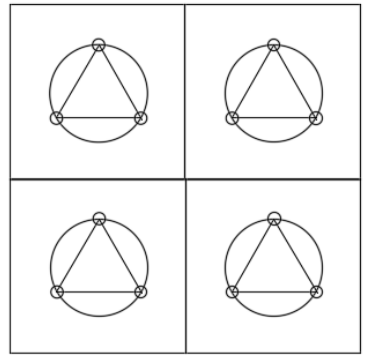
Figure 1. Drilling diagram of sample.